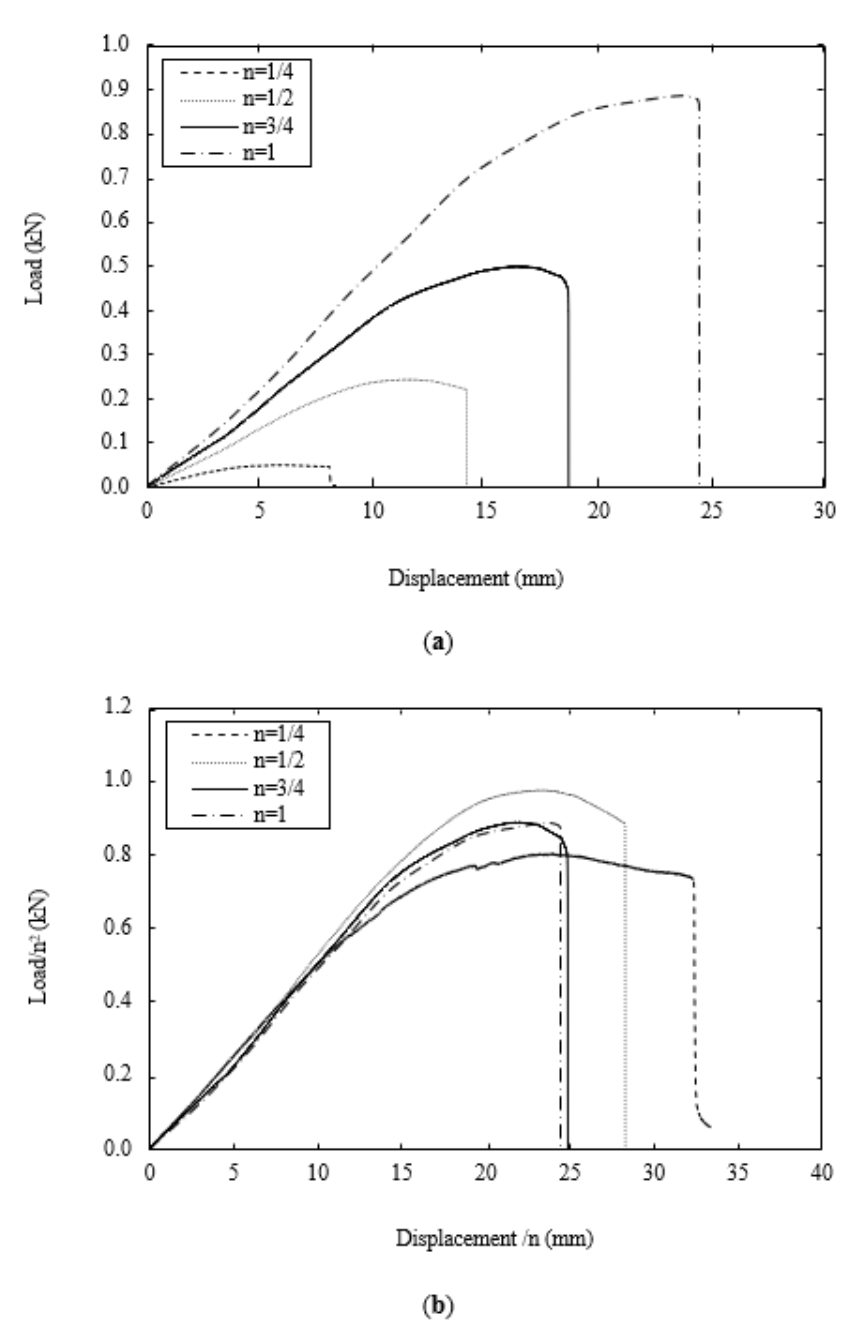
Figure 7. ( a ) Typical load–displacements traces following flexural tests on the rectangular samples. ( b ) Typical scaled load–displacements traces following flexural tests on the rectangular samples.